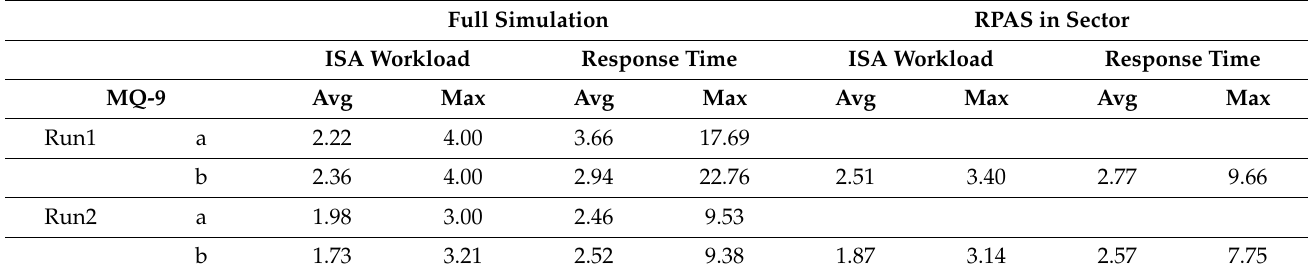
Table 12. ISA data recording for the MQ-9 nominal